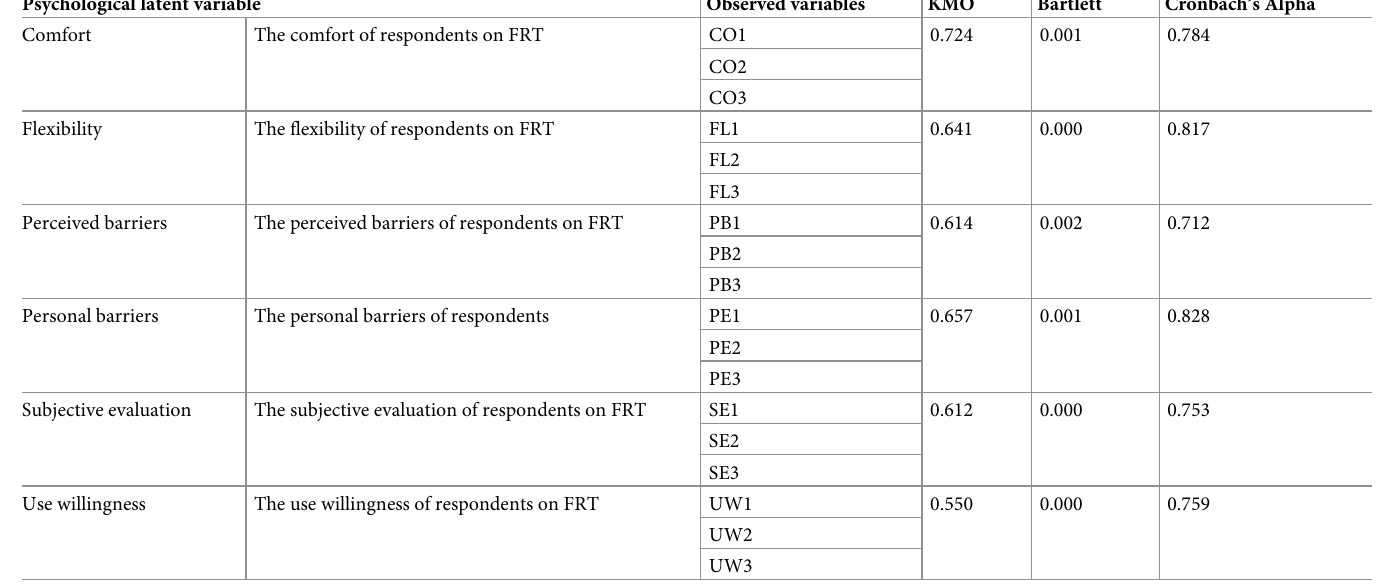
Table 3. The reliability and validity test of the samples. Psychological latent